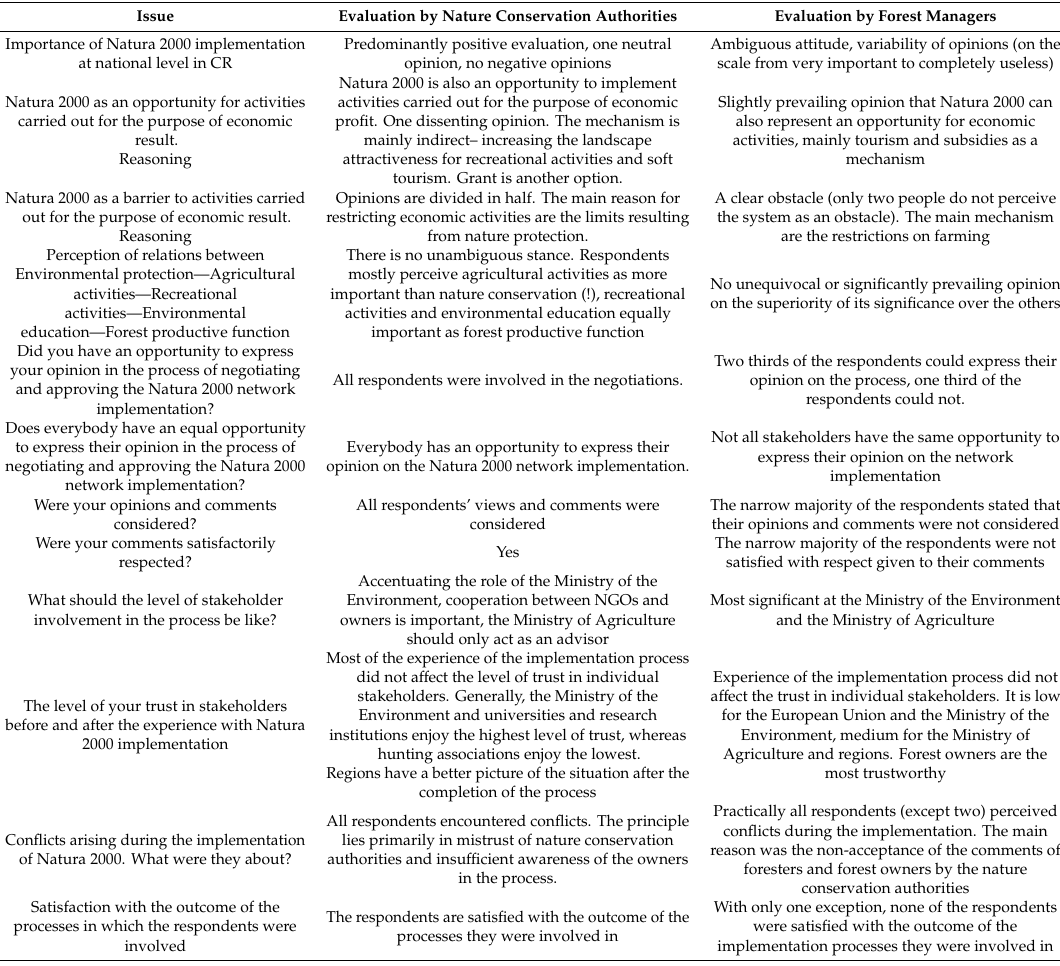
Table 5. Approach of the representatives of nature conservation authorities and forest managers in the implementation of the Natura 2000 network in the Czech